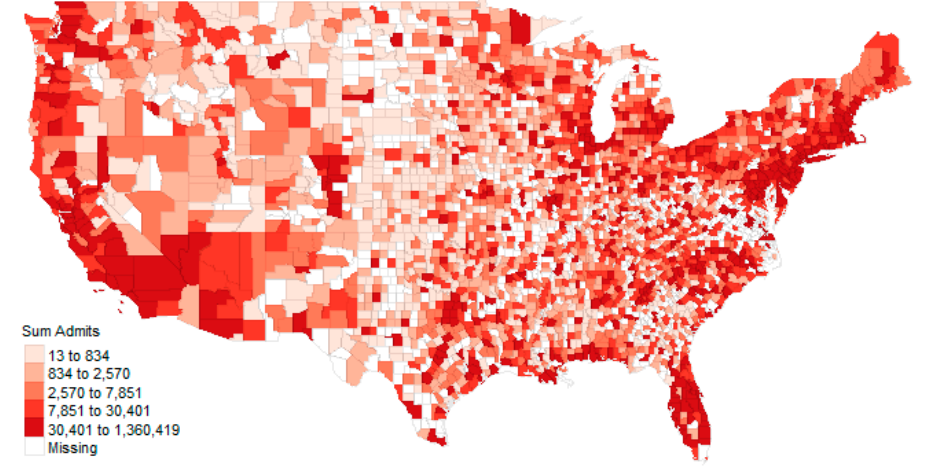
Figure 13. The total admissions from 2016 through 2018 by county.